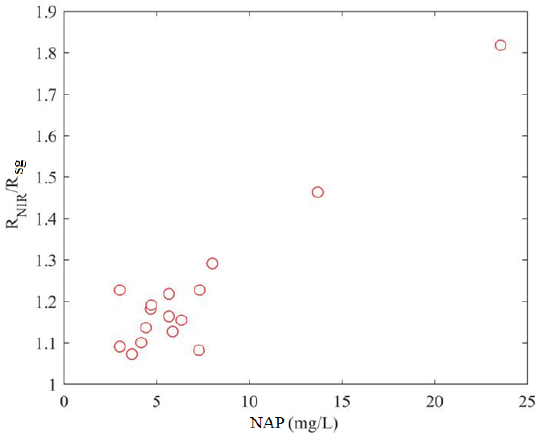
Figure 14. The ratio of reflectance at 825 nm to the value of the sun glint calculated by the Cox–Munk model versus NAP.